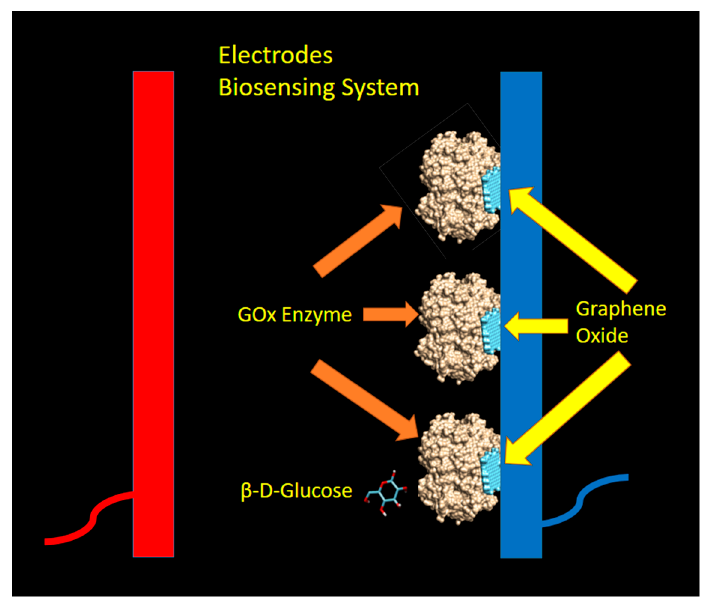
Figure 2. The model of biosensing mechanism utilizing glucose oxidase (GOx) enzyme and graphene as Immobilizer. The light blue color denotes the graphene oxides, while the gold color represents the GOx enzyme. The dark blue and red color bars represent the electrodes ( dark blue for the cathode, and red color for anode).